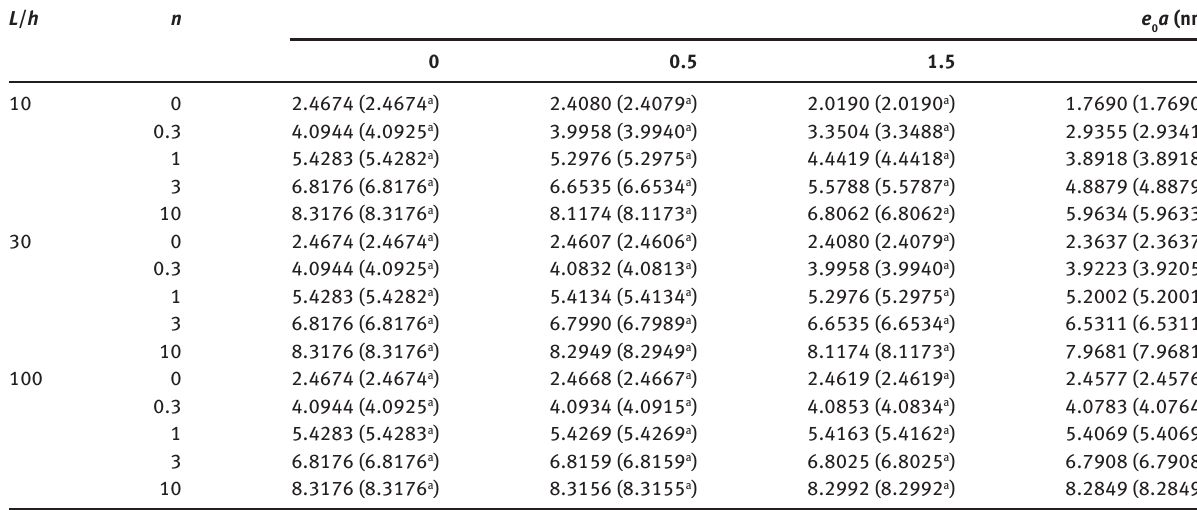
= PL 2 / E I , k = 0). dim 1